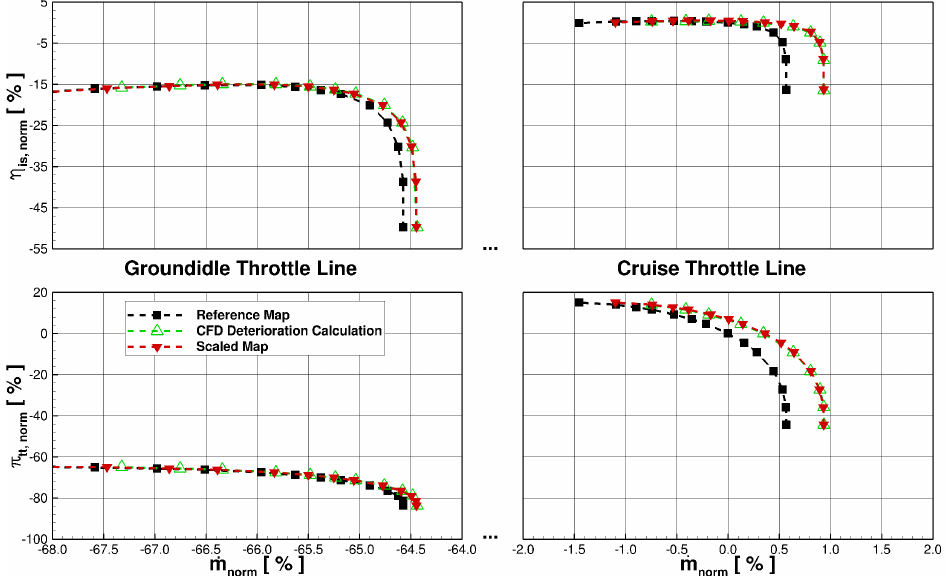
Figure 4. Validation of the HPC map scaling